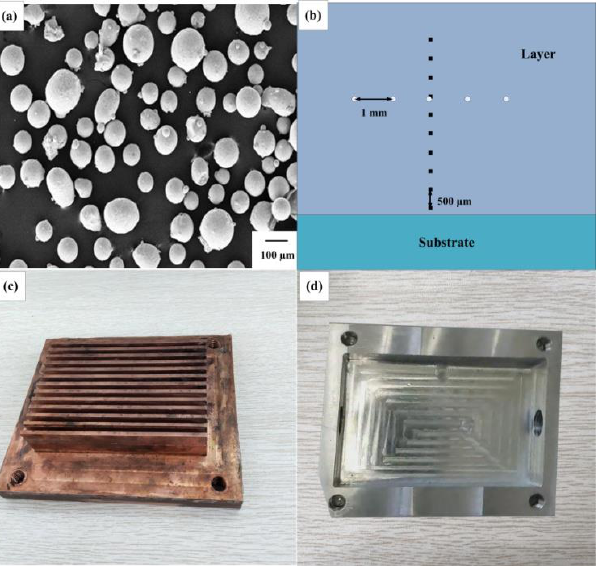
Figure 1. Experimental materials: ( a ) morphology of IN718 alloy powder (200×), ( b ) point location of hardness test; cooling device: ( c ) radiator, ( d ) water-flow groove .